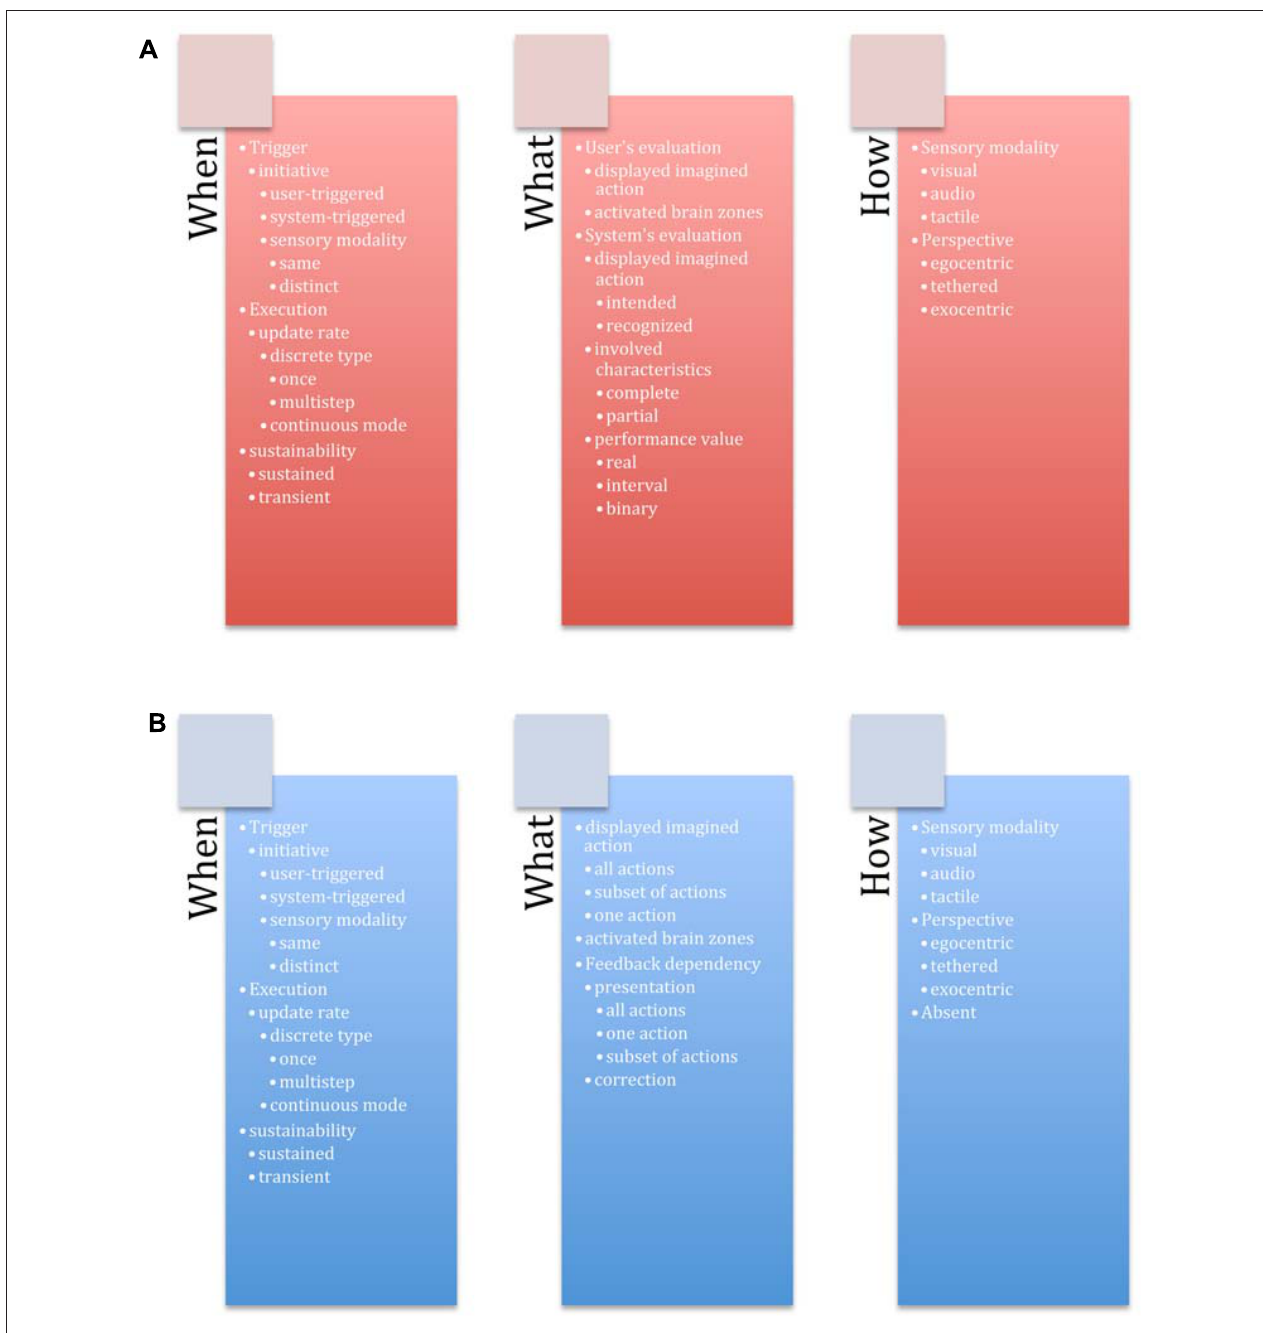
FIGURE 4 | Guiding system for BCIs with 28 axes organized according to two categories— (A) Feedback and (B) Feedforward. Each category is composed of three groups— When (temporal characteristics), What (content characteristics), How (medium characteristics).